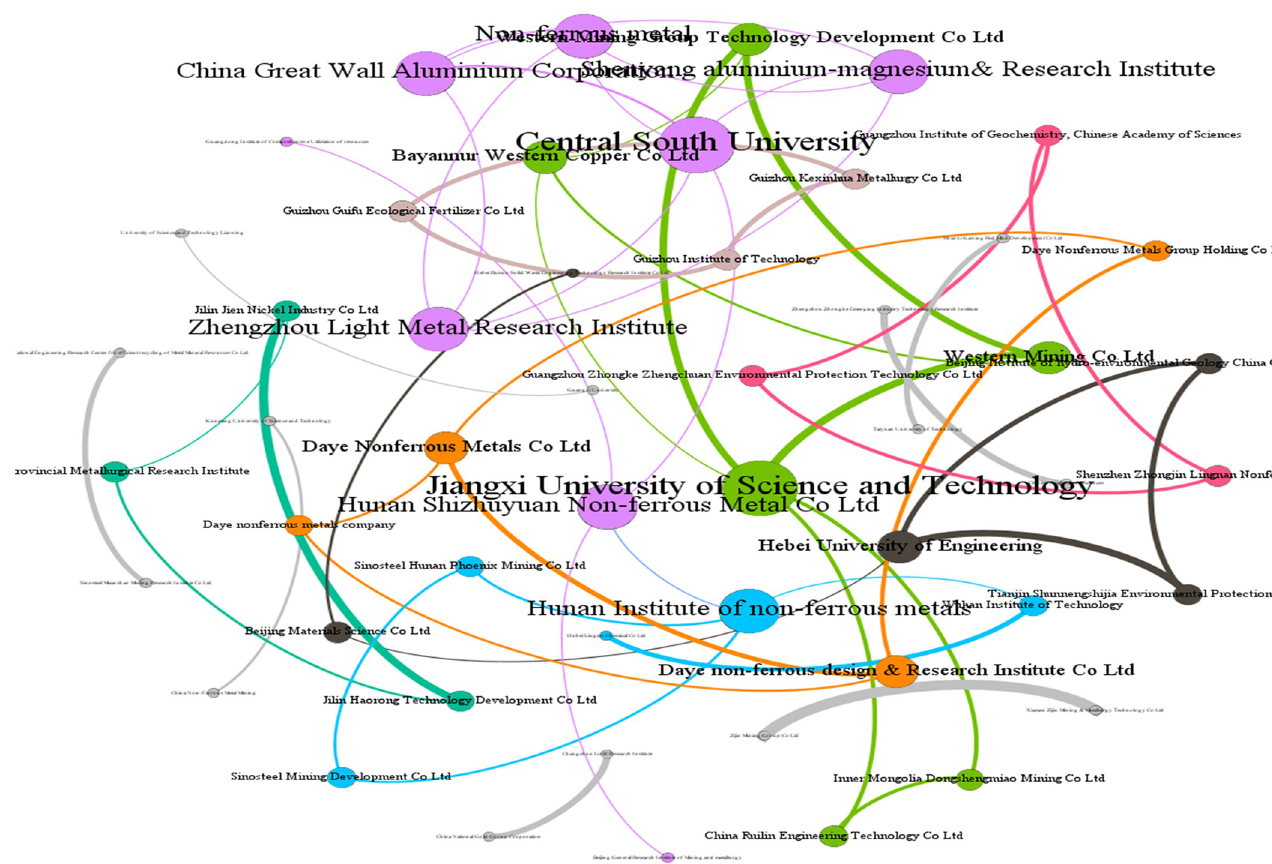
Fig 6. Major inter-organizational patent